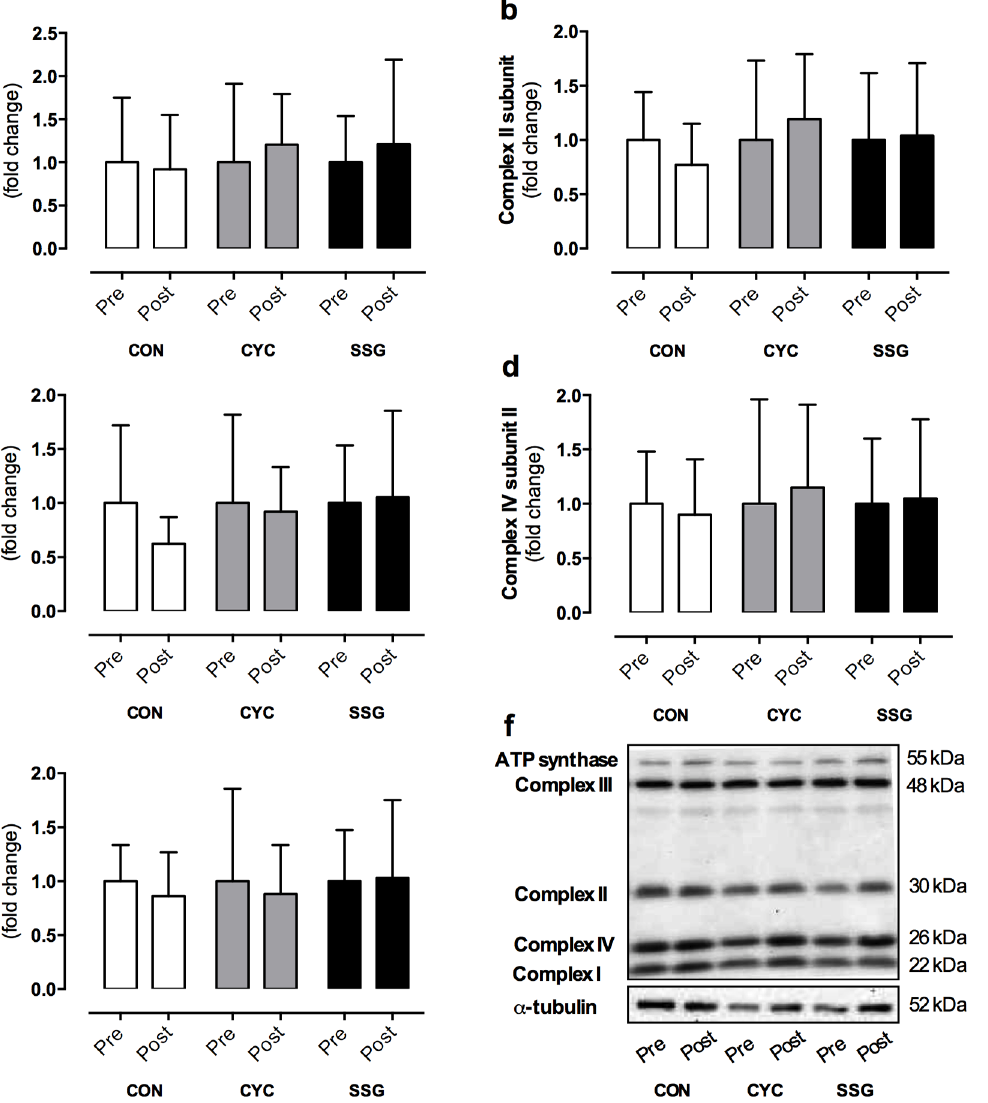
Fig 3. Total protein content of Mitochondrial Complex I subunit (a), Complex II subunit (b), Complex III subunit core2 (c), Complex IV subunit II (d), ATP synthase subunit- α (e) and representative blots corrected to α -tubulin (f) before (pre) and after (post) 8-weeks of control (CON; n = 9), continuous cycling (CYC; n = 11) or small-sided games (SSG; n = 10) conditions. Post values are expressed as fold change relative to pre values.